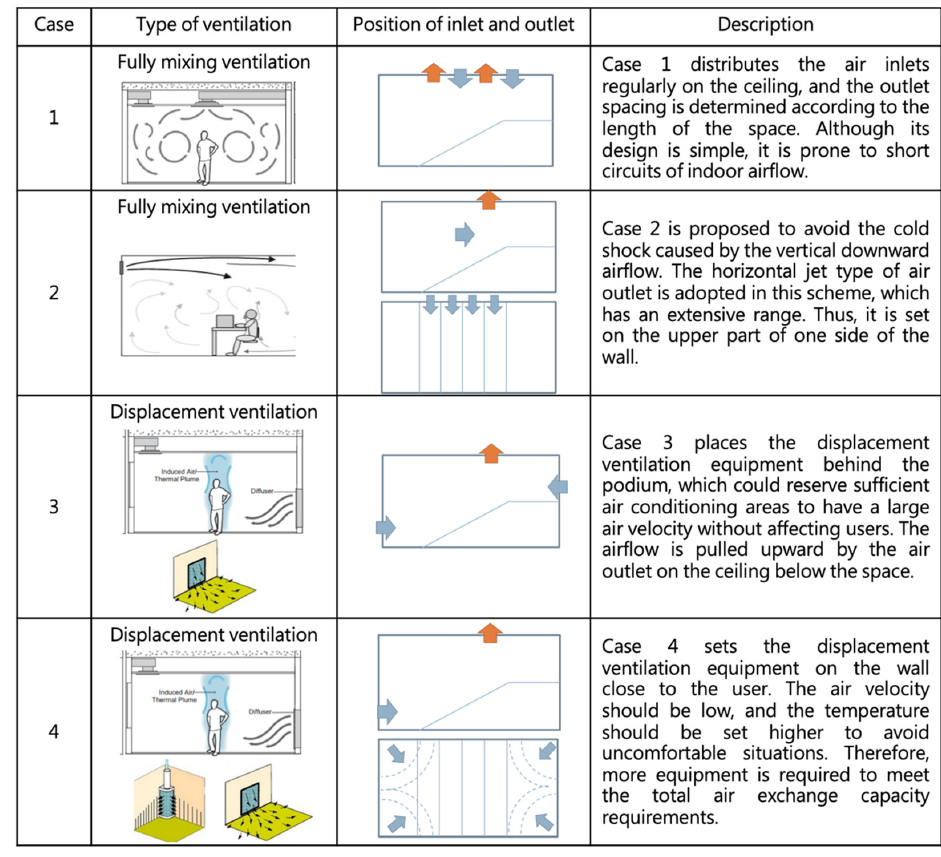
Figure 8. Detailed information on each case.